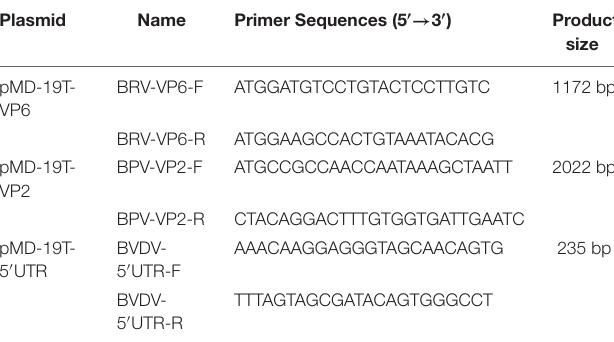
TABLE 2 | Primers used for preparation of the recombinant plasmids.